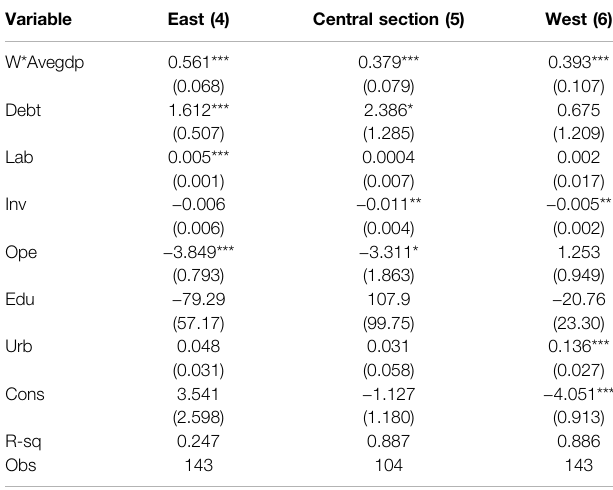
TABLE 6 | Regression results of SLM in eastern, central, and western regions of China.